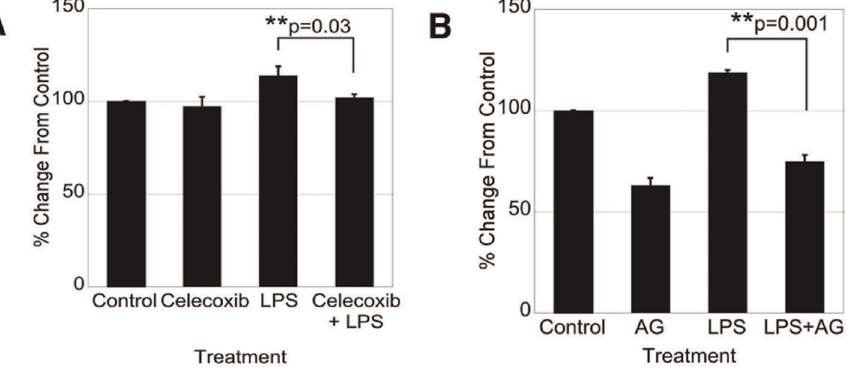
Figure 4. Stimulation of IEC-6 cell proliferation by LPS requires COX-2 activity. IEC-6 cells were treated with LPS (2 m g/mL) for 48 hours in the presence or absence of A) Celecoxib (10 m M) or B) AG1478 (1 m M). Cell numbers were determined by a Nucleocassette counter. Celecoxib and AG1478 treatment significantly blocked LPS-induced proliferation (p=0.03 and 0.001 respectively).